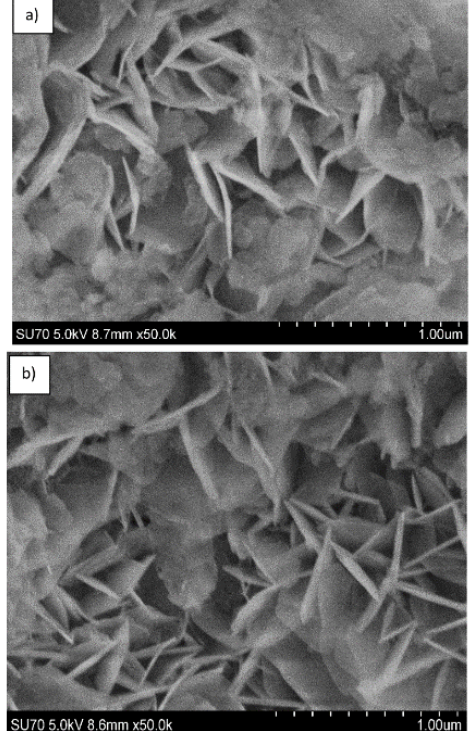
Figure 10. SEM micrographs of Mg 3 /Al-oxalate ( a ) and Mg 3 /Al-4-biphenylacetonate ( b ) LDHs.